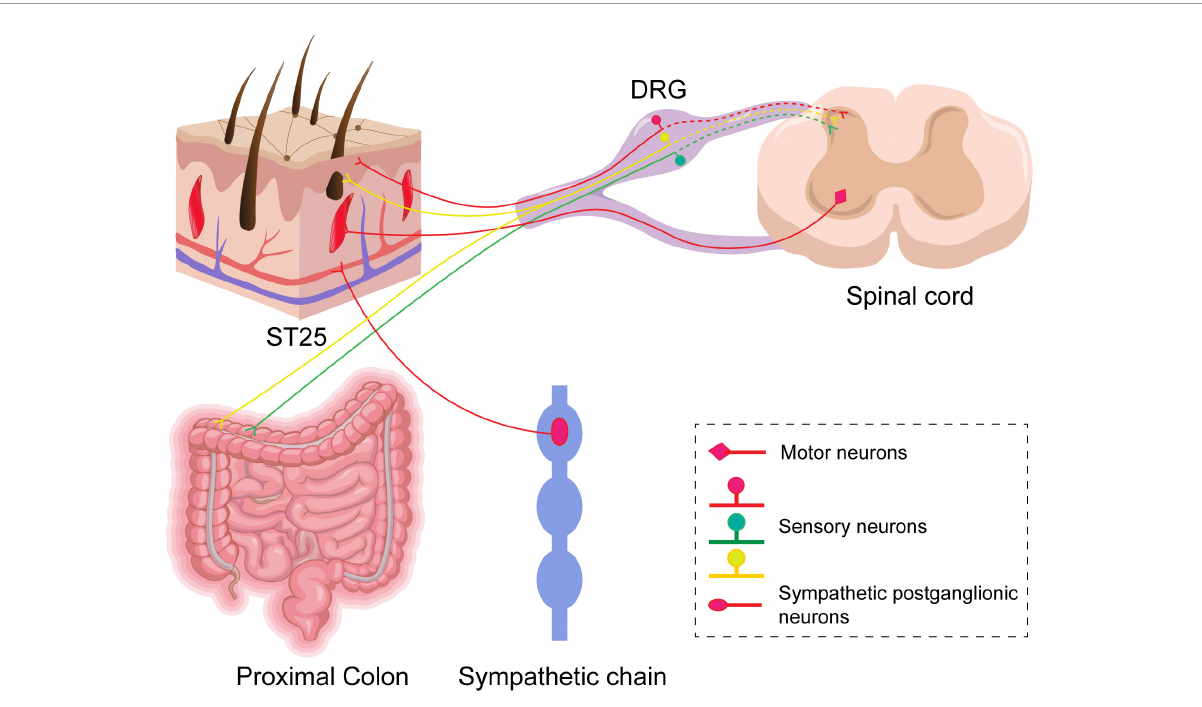
FIGURE9 A schematic diagram of sensory and motor innervations of ST25 and the colon in rats. Labeled sensory neurons in the dorsal root ganglia (DRGs) innervate ST25 and the colon, respectively, and their central synapses project to the posterior horn of the spinal cord. There are a small number of co-labeled neurons in the DRGs. Postganglionic neurons in the sympathetic chain and motor neurons in the anterior horn of the spinal cord are relative to ST25